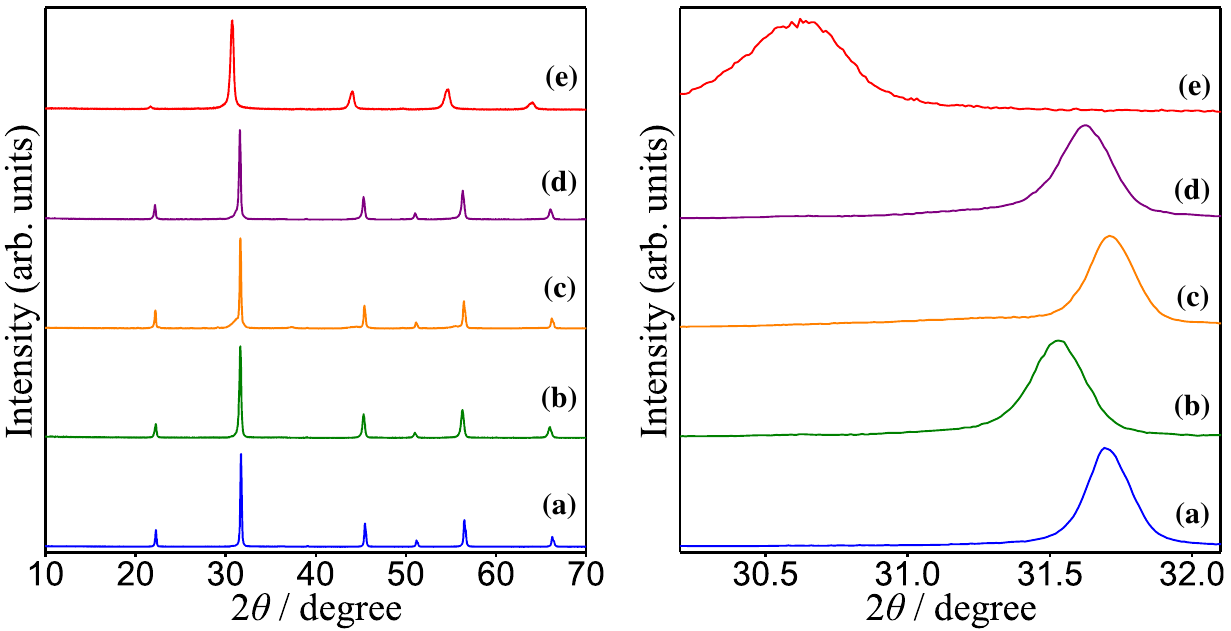
Fig. 3 XRD patterns of Sr 1 - x Ba x W 1 - y Ta y (O,N) 3 : ( a ) x , y = 0,0; ( b ) x , y = 0.25,0; ( c ) x , y = 0,0.25; ( d ) x , y = 0.125,0.125; and ( e ) BaTa(O,N) 3 crystal structures synthesized by thermal ammonolysis of oxide precursors at 900–950 (cid:3) C for 10–40 h under an NH 3